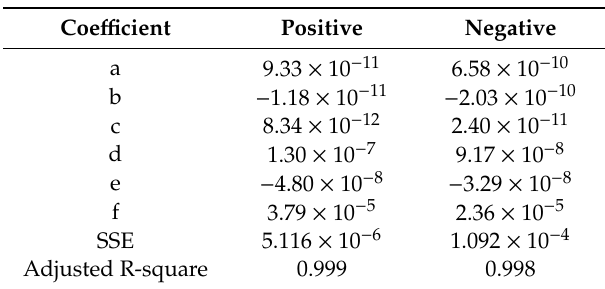
Table 1. List of coe ffi cients and goodness of